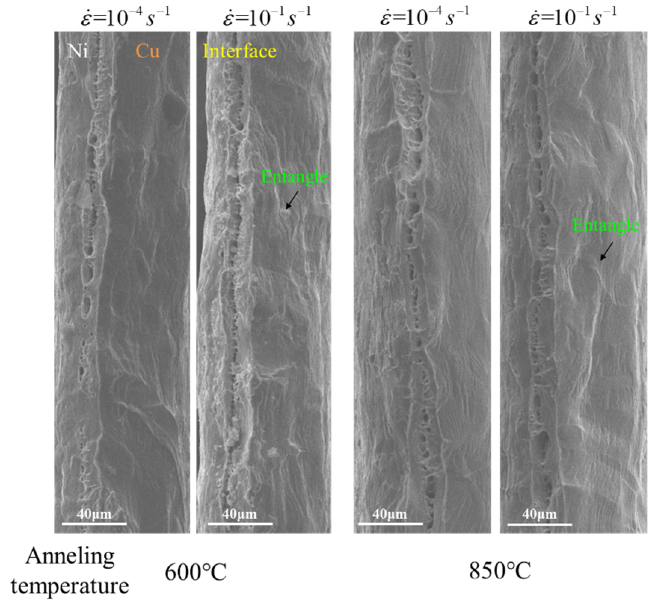
Figure 9. Fracture topography of specimens with different annealing conditions at various strain rates.